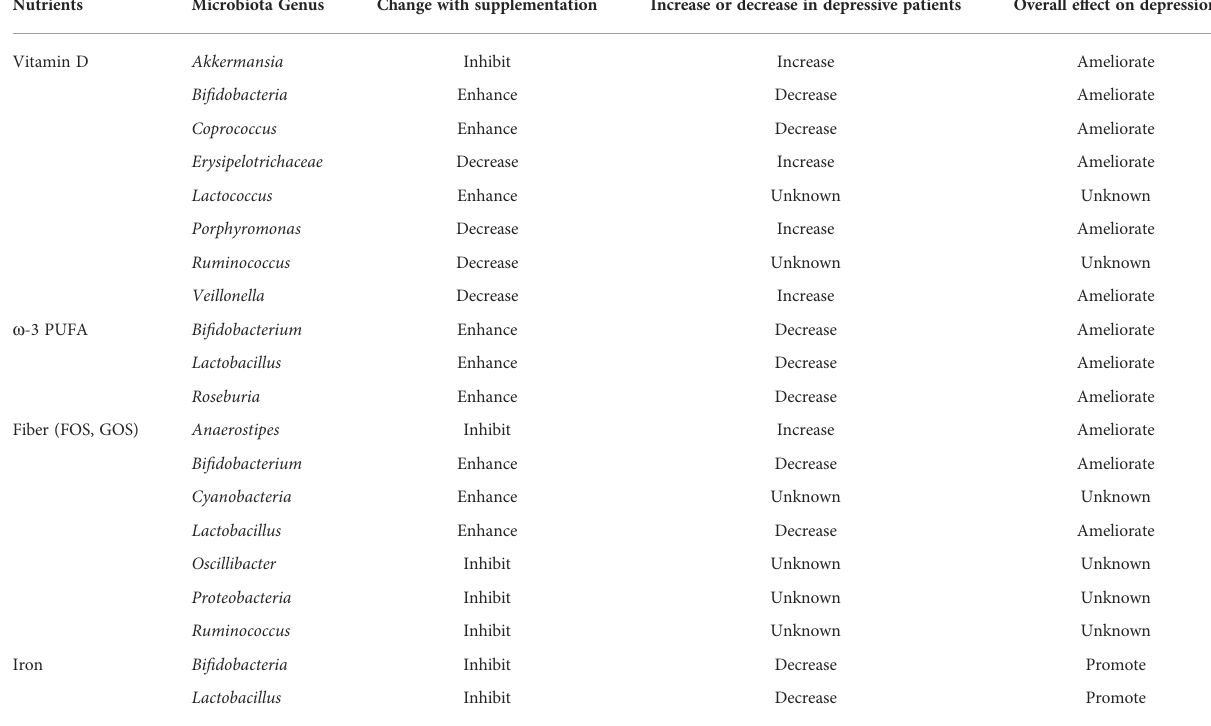
TABLE 1 The effects of nutrients on the gut microbiota and